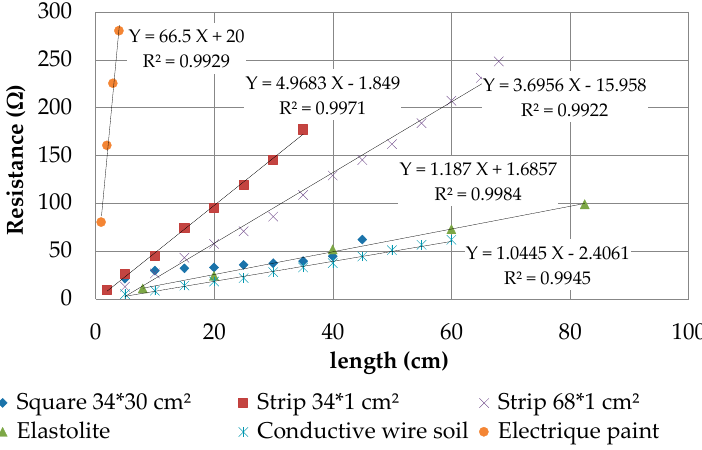
Figure 8. Resistance of conductive supports as function of its length.